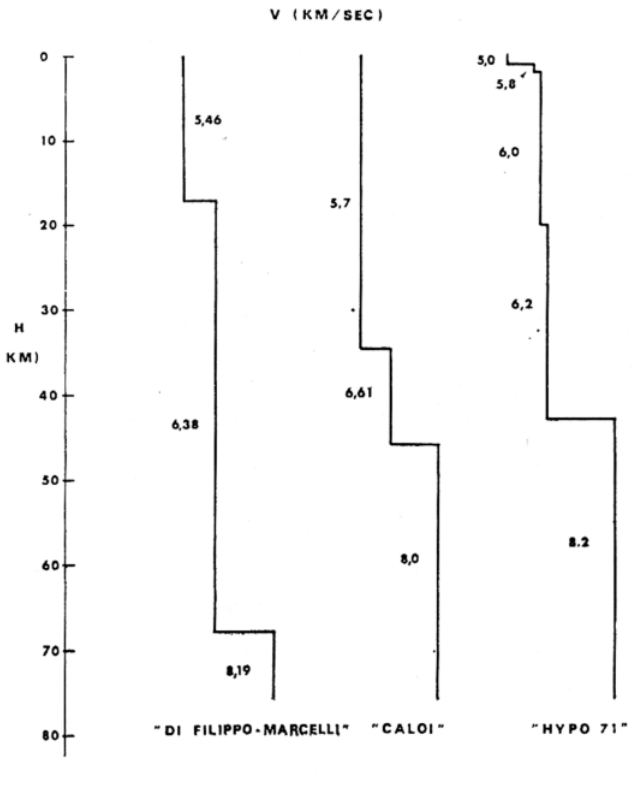
Figura 1. Modelli crostali delle dromocrone sperimentali.